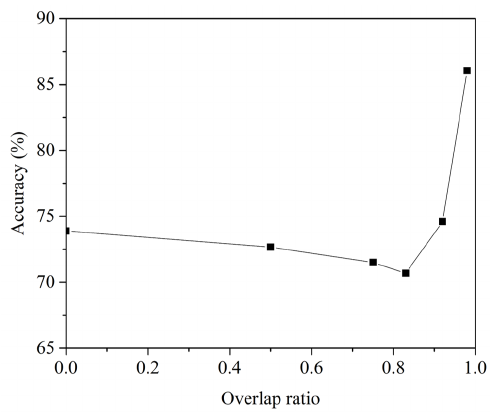
Figure 9. Accuracy of subnetwork according to overlap ratio ( w =